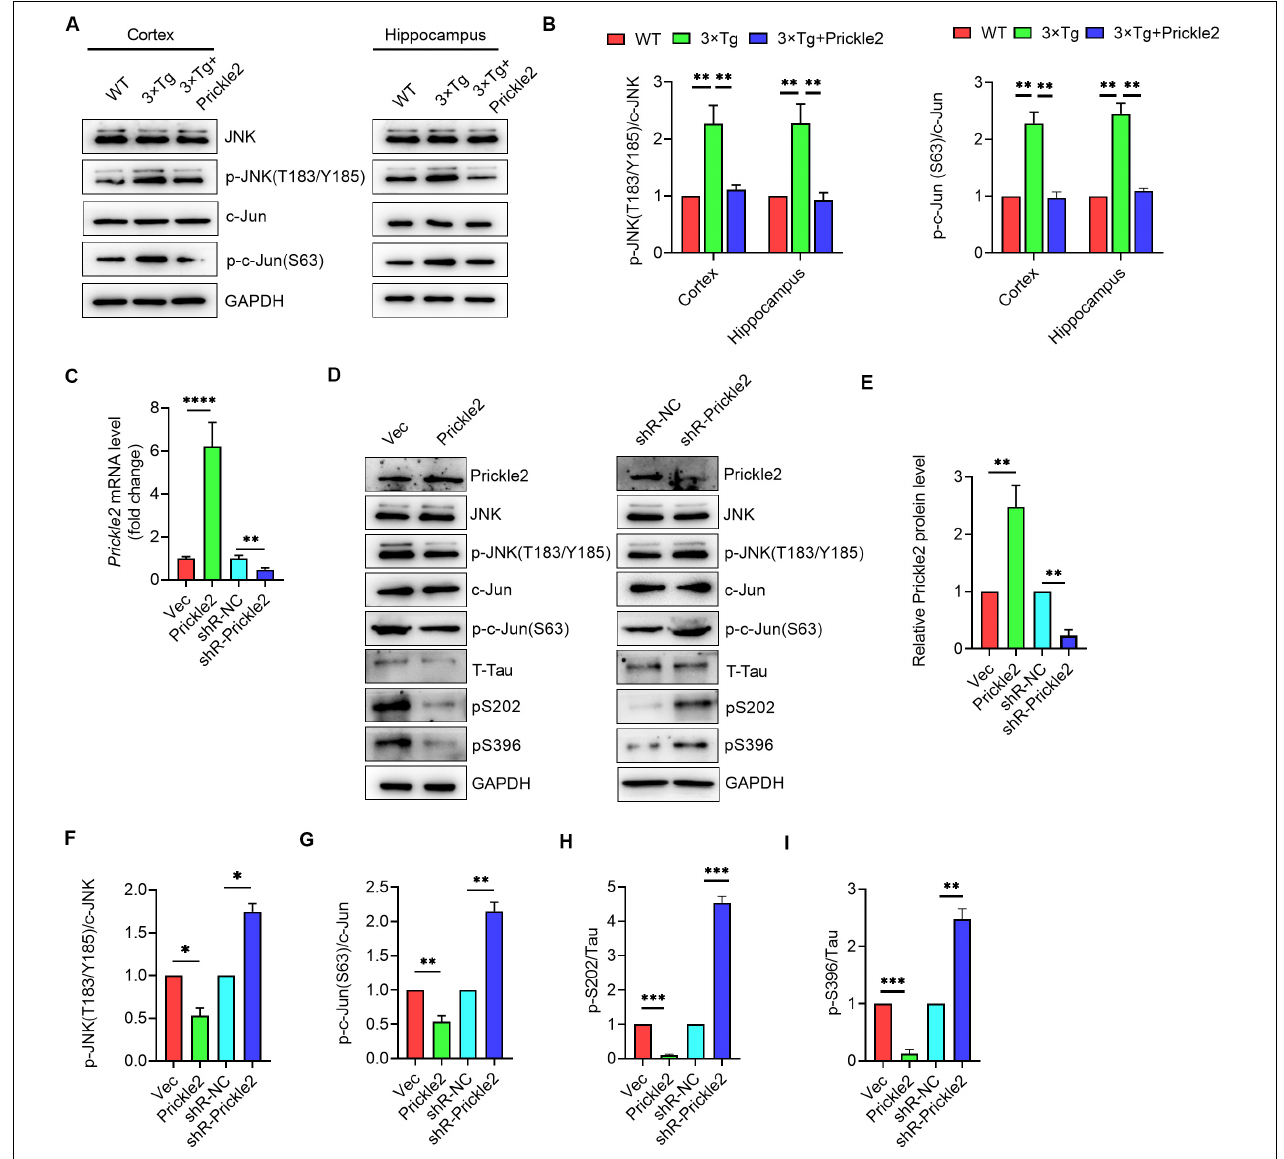
FIGURE 6 | Prickle2 treatment ameliorates AD-like pathology through Wnt/PCP pathway. (A) Western blotting analysis of protein levels of JNK, p-JNK (T183/Y185), c-Jun, and p-c-Jun (S63) in brain tissues from WT, 3 × TG and 3 × TG/Prickle2 treatment mice ( n = 6 per group). (B) Quantification of the protein levels of p-JNK (T183/Y185) and p-c-Jun (S63) by densitometric analyses ( n = 6 per group). (C) Prickle2 mRNA ( n = 3 per group) in N2a/APP695sw cells transfected with empty vector pcDNA3 (Vec), pcDNA3-Prickle2, pSilencer 2.1-U6 neo (shR-NC), and pSilencer-Prickle2 (shR-Prickle2). (D) Western blotting analysis of protein levels of Prickle2, JNK, p-JNK (T183/Y185), c-Jun, p-c-Jun (S63), Tau, p-Tau S202 and p-Tau S396 in N2a/APP695sw cells transfected with indicated plasmids or siRNAs. (E–I) Quantification of the protein levels of Prickle2, p-JNK (T183/Y185), p-c-Jun (S63) p-Tau S202 and p-Tau S396 by densitometric analyses ( n = 3 per group). (B,C,E–I) ANOVA followed by Bonferroni’s post hoc test. ∗ p < 0.05; ∗∗ p < 0.01; ∗∗∗ p <